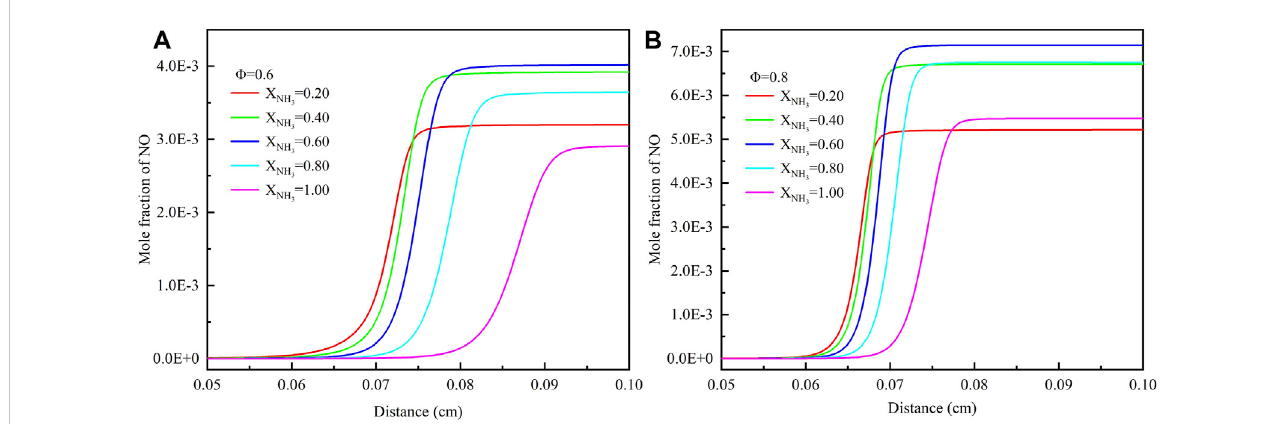
FIGURE 10 Mole fraction of NO with different ammonia content: (A) Φ = .6; (B) Φ = .8. (T = 723 K, p = 16.5 atm).